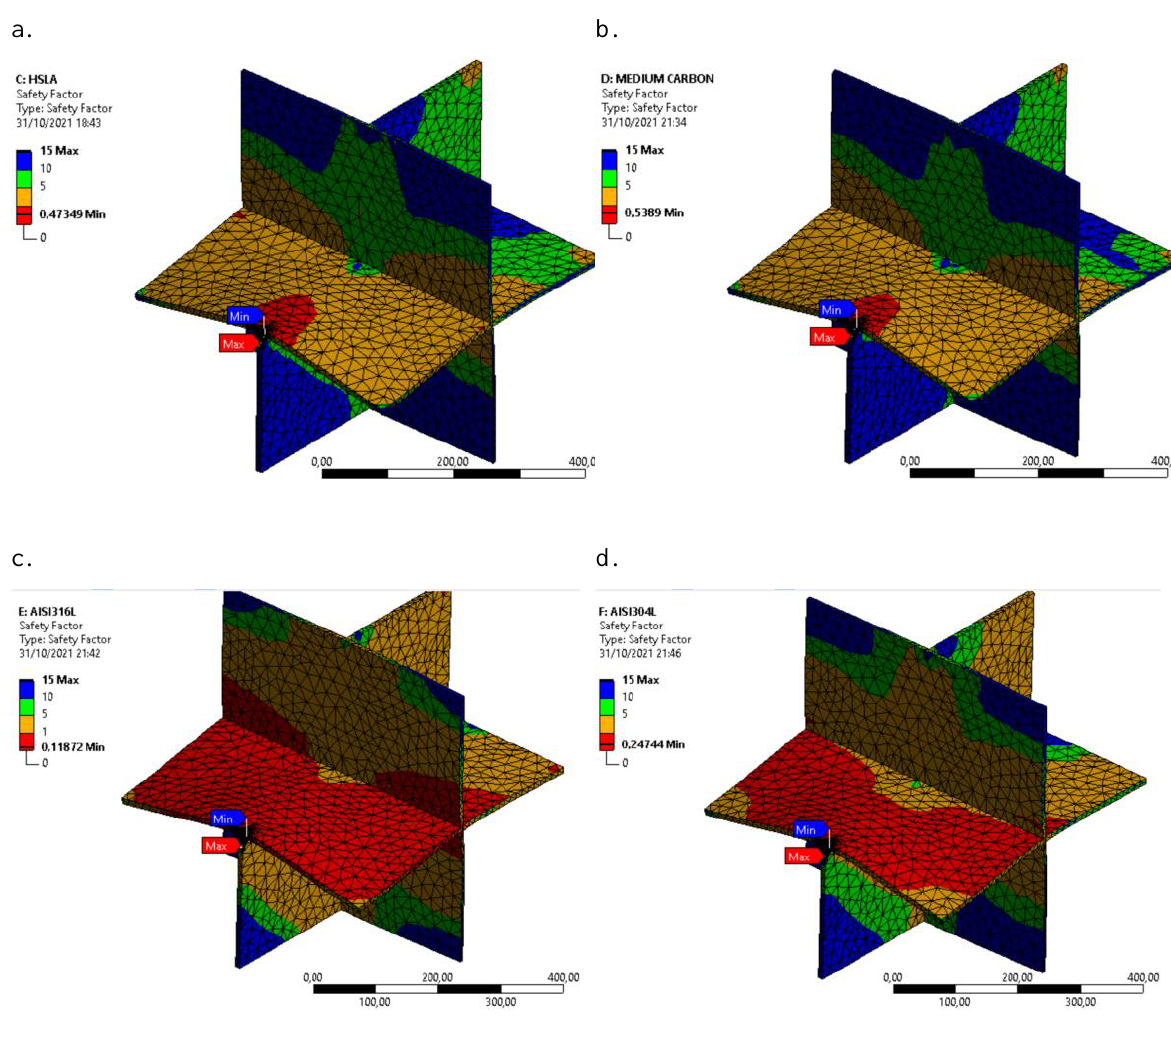
Figure 19: Safety factor: a. HSLA 950X; b. Medium-carbon; c. SAE 316L; d. SAE 304L Figure 19. Safety Factor: a. HSLA 950X; b. Medium-Carbon; c. SAE 316L; d. SAE 304L